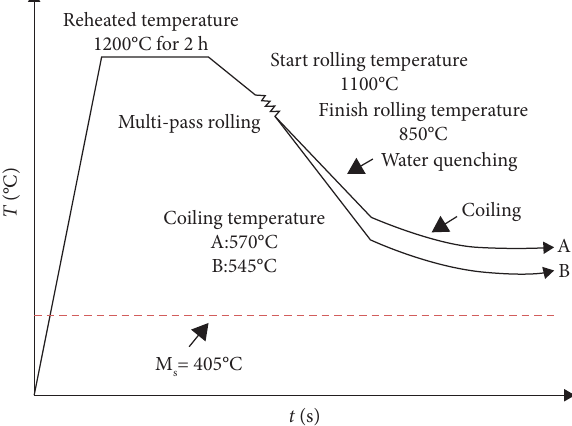
Figure 2: Schematic diagram of hot rolling and cooling